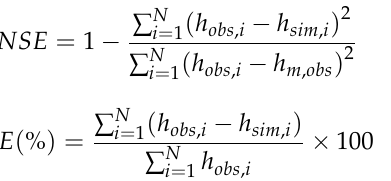
Figure 3. Catchment discretization for 1-D river flow